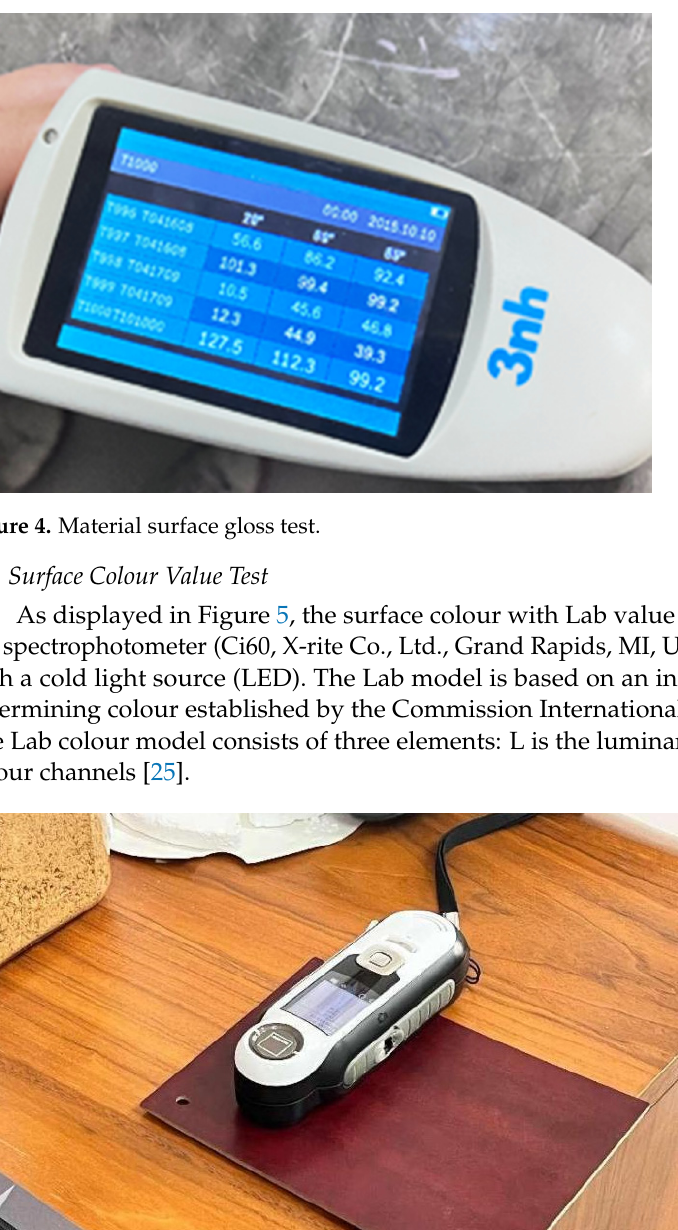
Figure 3. Material surface cooling rate test.